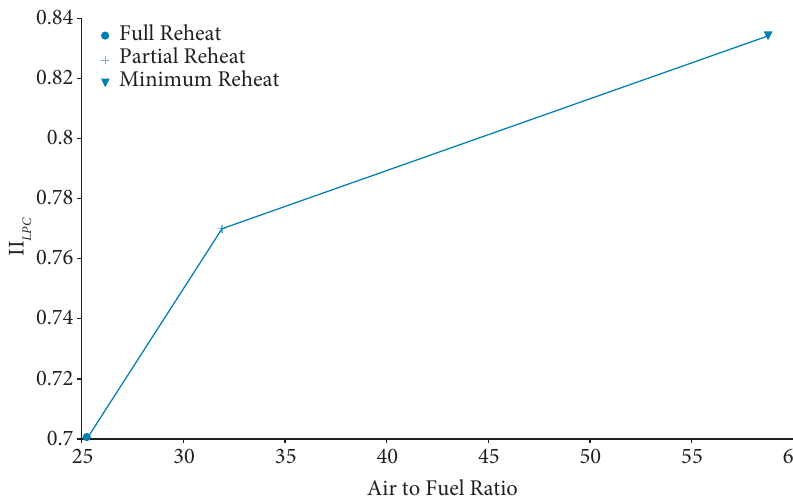
Figure 12. AB efficiency as a function of air-to-fuel